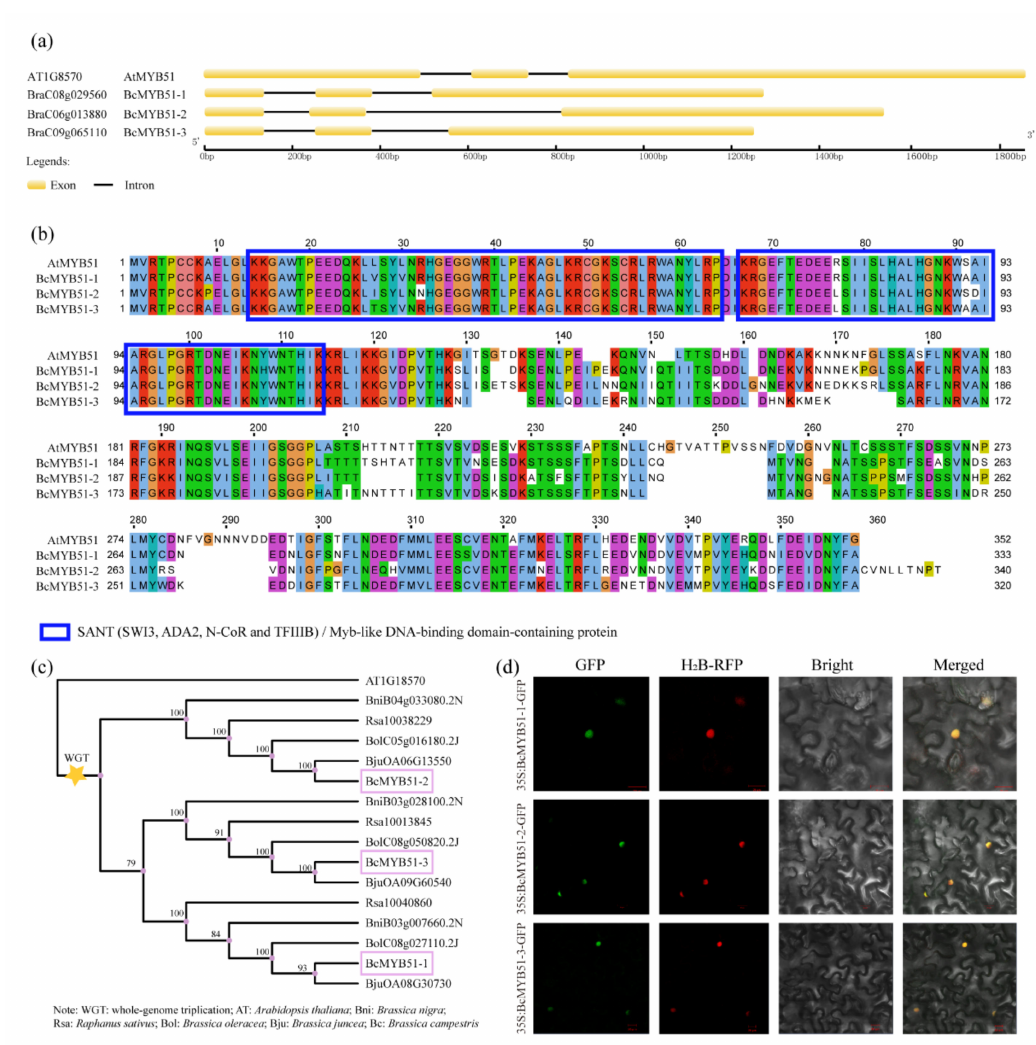
Figure 3. Identification of three BcMYB51-like proteins. ( a ) Gene structures of BcMYB51s and AtMYB51. ( b ) Alignment of sequences of BcMYB51s and AtMYB51. ( c ) Phylogenetic analysis